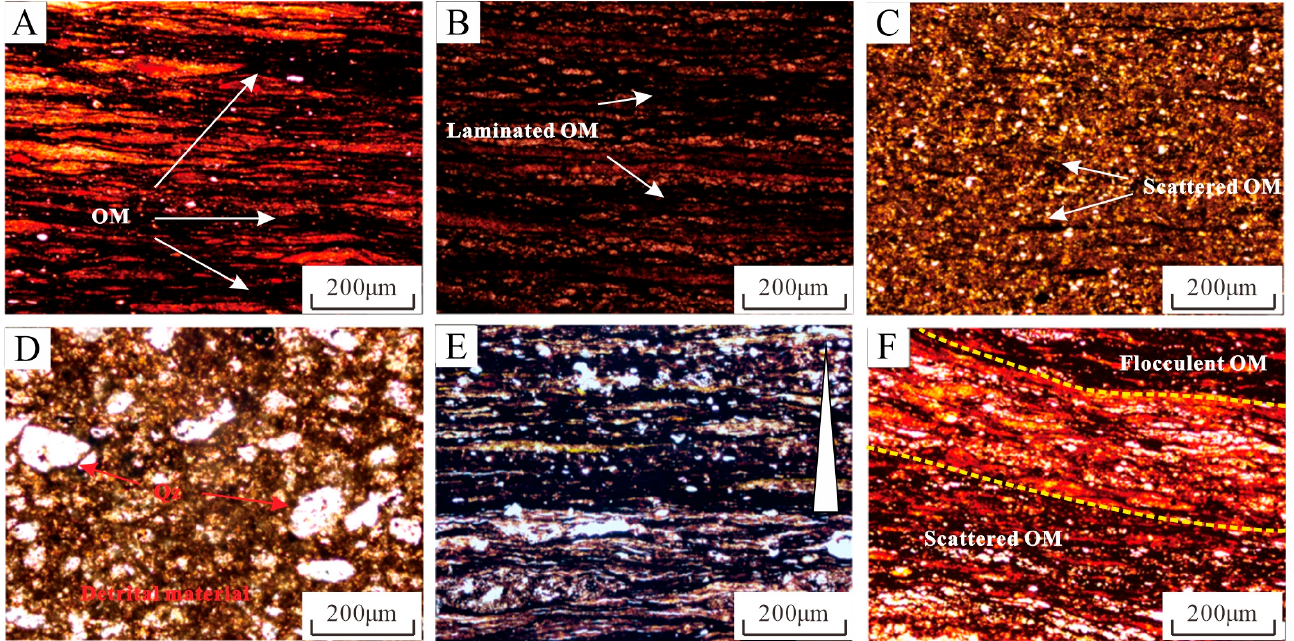
Figure 3. Organic matter distribution in the Chang 7 shales of the Ordos Basin. ( A ) Laminated organic matter, Sample 2; ( B ) laminated organic matter with dotted silt, Sample 4; ( C ): patchy organic matter, Sample 21; ( D ) calcite seen within organic matter bands, Sample 24; ( E ) the scattered organic matter with high silty sand content, Sample 10; ( F ) uneven distribution of organic matter, Sample 7. OM = Organic matter; Qz = Quartz.